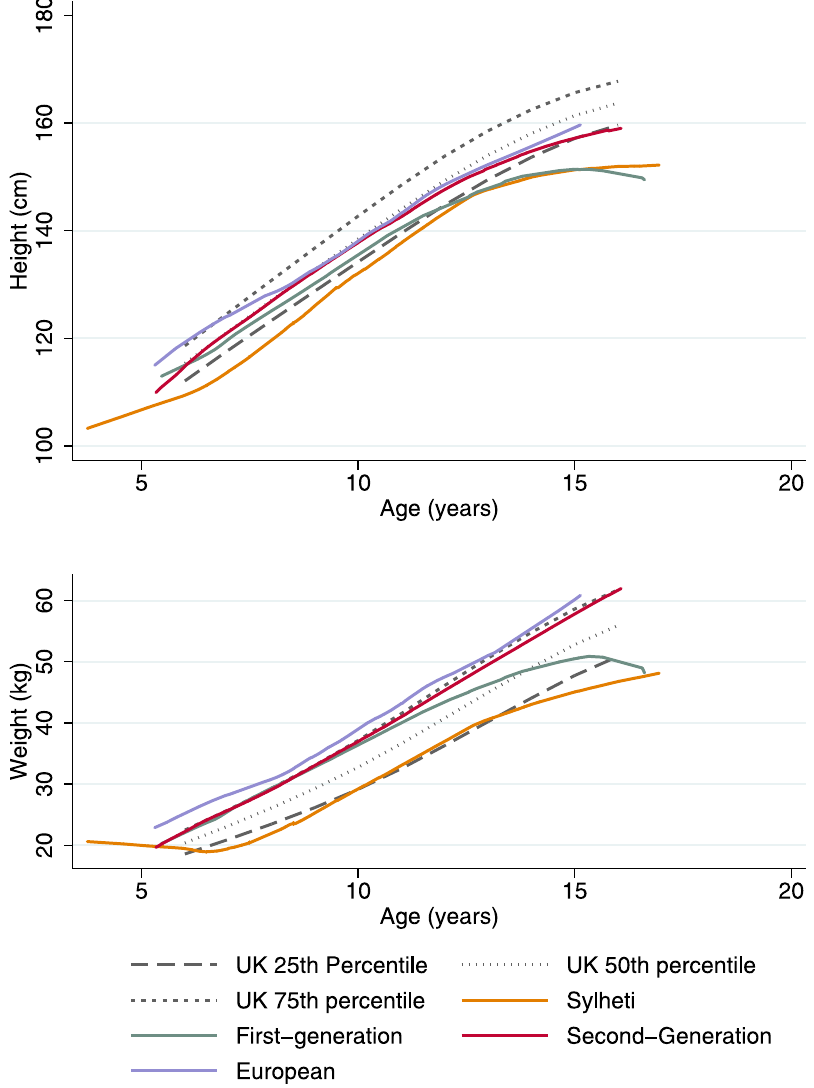
Figure 1. Height and Weight by among girls aged 5–6 in the ABBY Project. (Upper) Lowess smoother of height and age for each group compared with the UK 1990 Growth References, (Lower) Lowess smoother of weight and age for each group compared with the UK 1990